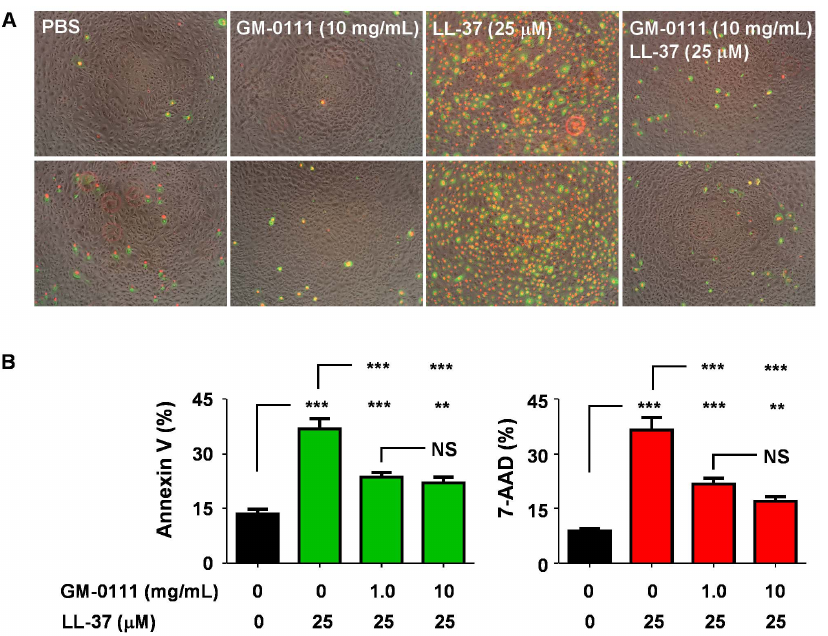
Figure 9. GM-0111 reduces LL-37 induced apoptosis in human urothelial cells (HUCs). HUCs pretreated with GM-0111 at 0, 0.1, 1.0, and 10 mg/mL for 30 min were challenged with LL-37 (25 m M) for 15 min at 37 u C. Cells were stained with annexin V-FITC (shown in green) and 7-AAD (shown in red) to visualize (A) with microscopy (magnification 10 x ) and to quantify (B) the apoptotic cells with flow cytometry. ** p , 0.01, *** p , 0.001 and NS, not significant ( p . 0.05) by Dunnet’s t -test.